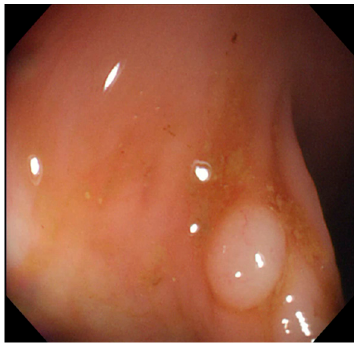
Figure 7. Polyp image before gray scaling.